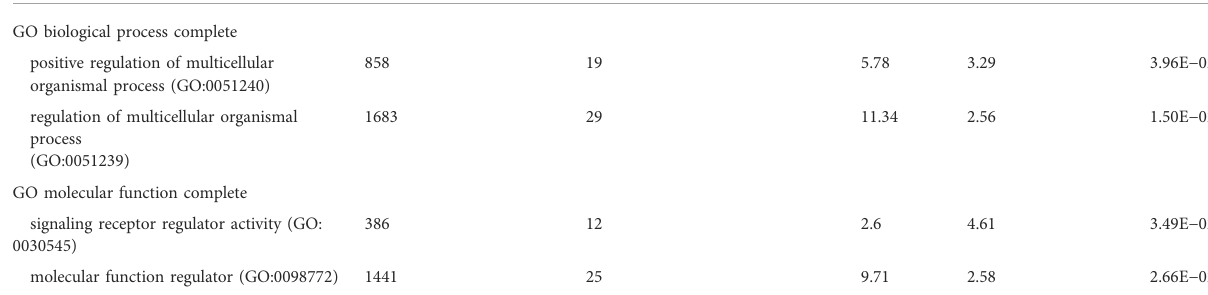
(Supplementary Table S2). Expression of 388 genes was signi fi cantly higher in the NCT cells with 104 down